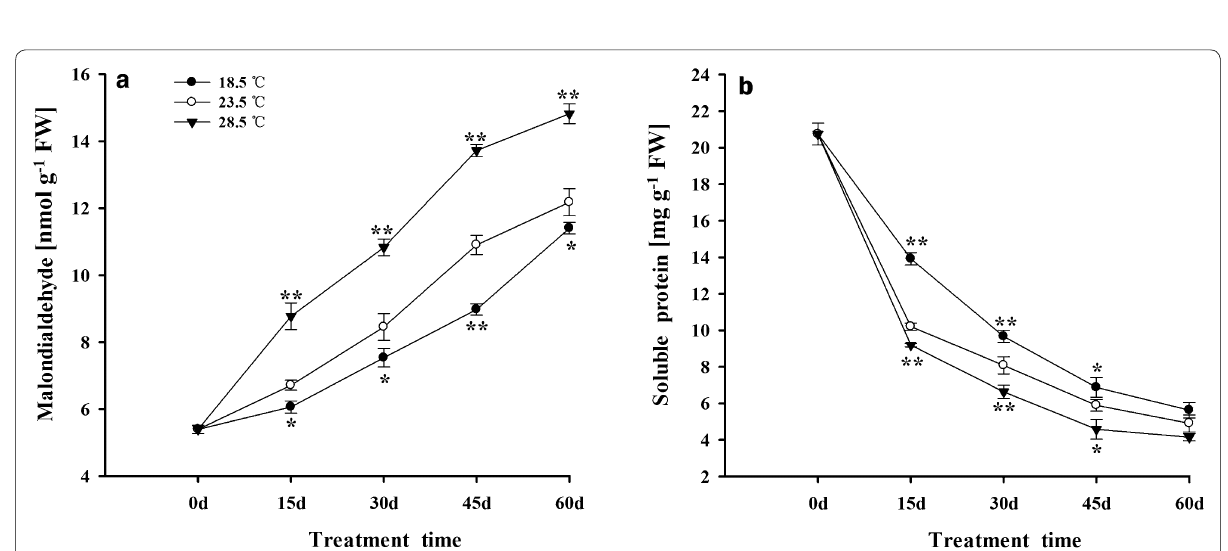
Fig. 2 Effects of different growth temperatures on leaf length ( a ) and width ( b ) of tobacco leaves. Level of significant difference: ** and * indicate significant difference at P 0.01 and P 0.05, respectively, same as the following figures ≤ ≤